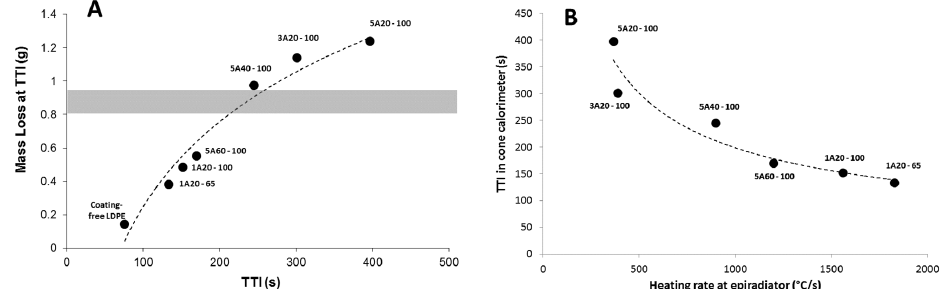
Figure 11. ( A ) Masse loss at time ‐ to ‐ ignition (TTI) for all formulations at 35 kW/m 2 (the grey zone corresponds to the mass of low ‐ density polyethylene (LDPE) in the coating); ( B ) Time to ignition in cone calorimeter at 35 kW/m 2 versus heating rate measured using epiradiator (the dotted line is only a guideline for the eyes—labels correspond to the coating thermocompressed on the top surface of LDPE sheet).